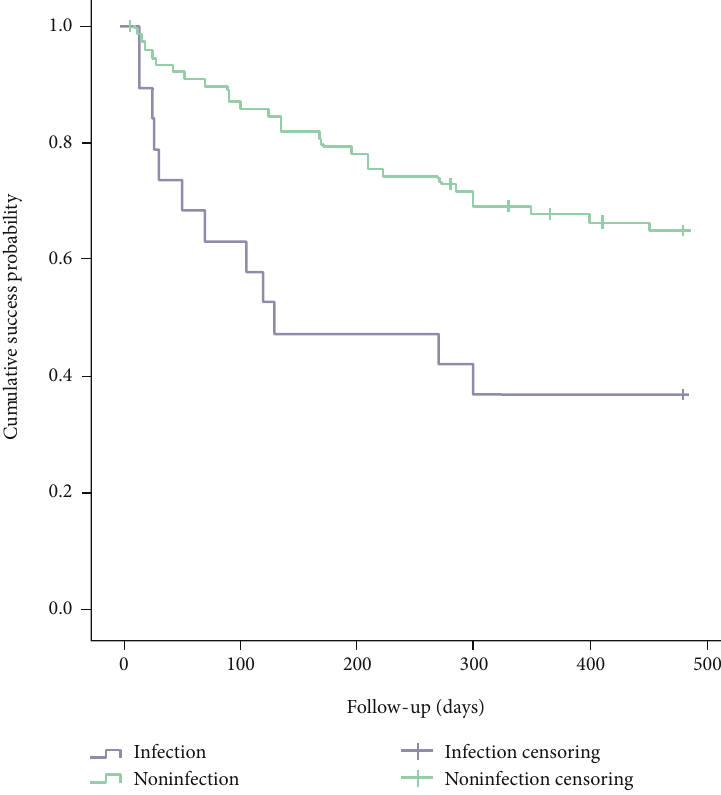
Figure 2: Comparison of survival curve between corneal infection group and noninfection